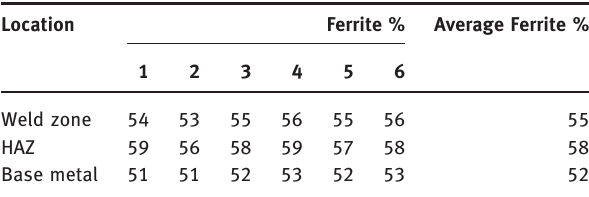
Table 12: Measurement of Ferrite content in welded 2205